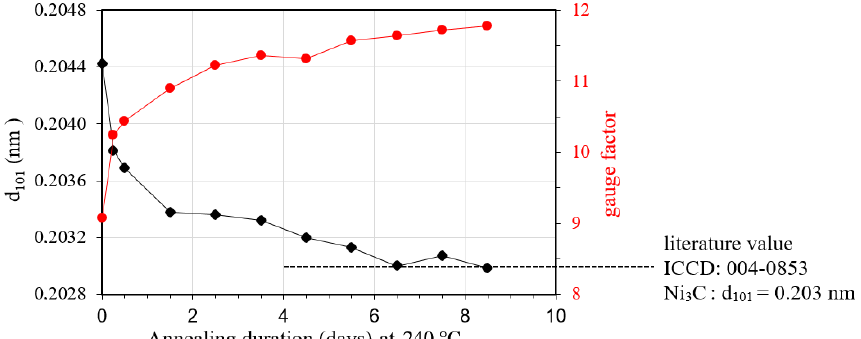
Figure 4. Evolution of the lattice plane spacing d 101 and the gauge factor of Ni 90 Cr 10 -C layers annealed in air at 240 ◦ C for a total duration of 8.5d. (1) The gauge factors measured by four-point bending were converted to the values of the radius method and thus adjusted for the influence of transverse contraction. (2) The gauge factor in this series does not start at 11 (as in Table 1), but at about 9. This is attributed to slightly different coating parameters.